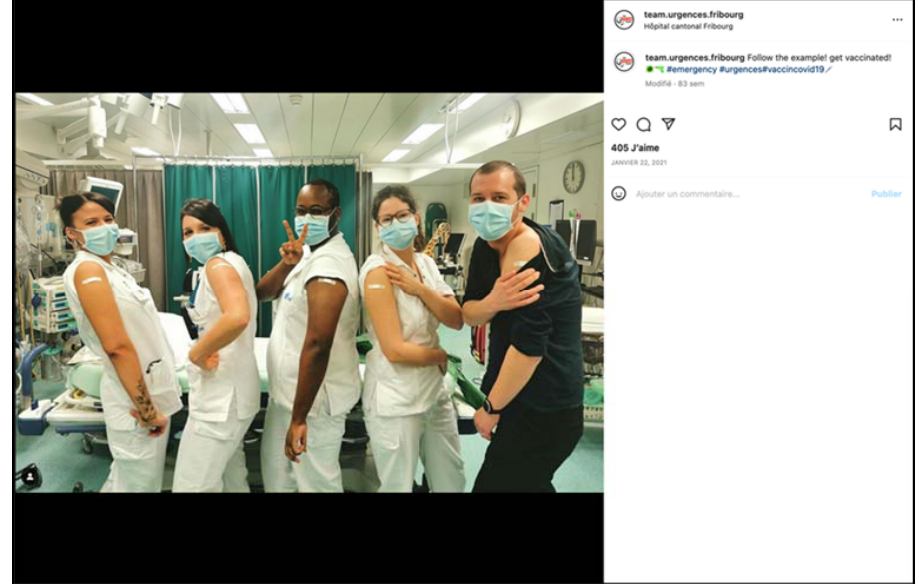
Figure 8. Vaccination campaign during the COVID ‐ 19 pandemic (screenshot).